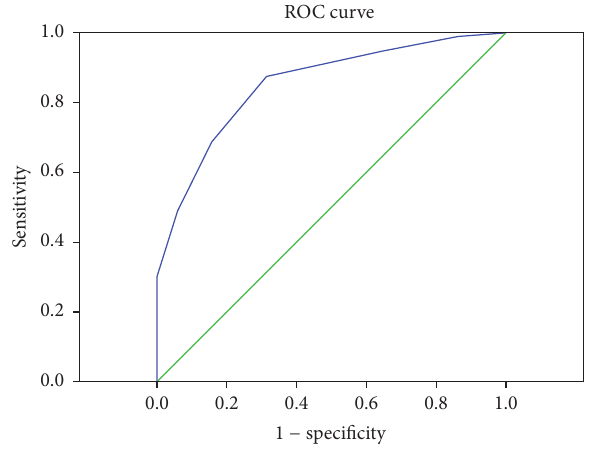
Figure 5: AUROC of HbA1c-based score model. Table 4: Death risk in stratified score